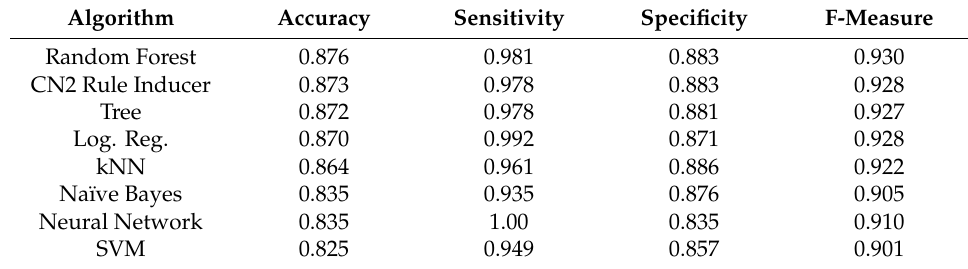
Table 6. Data transformation (equal width), feature selection (information gain).